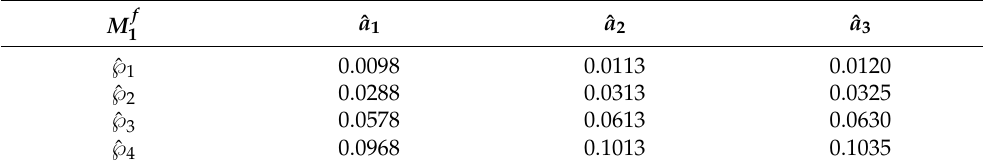
with entries in terms of fuzzy values. 1